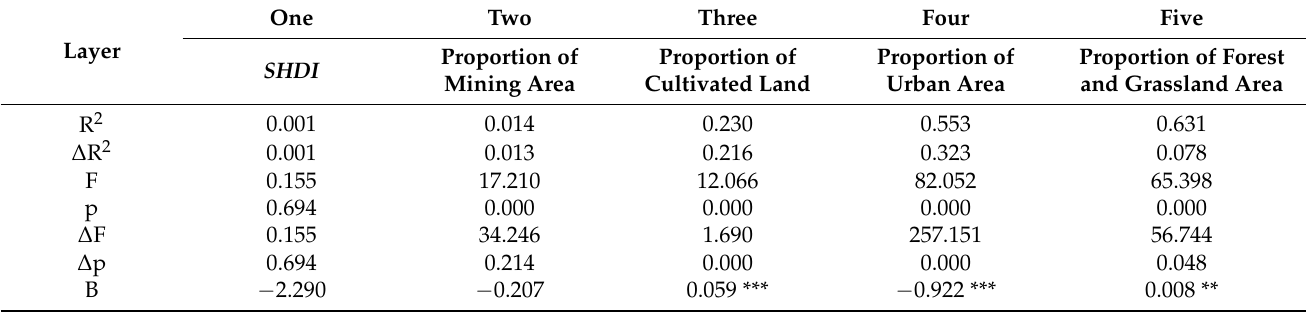
Table 4. The results of hierarchical multiple regression of the